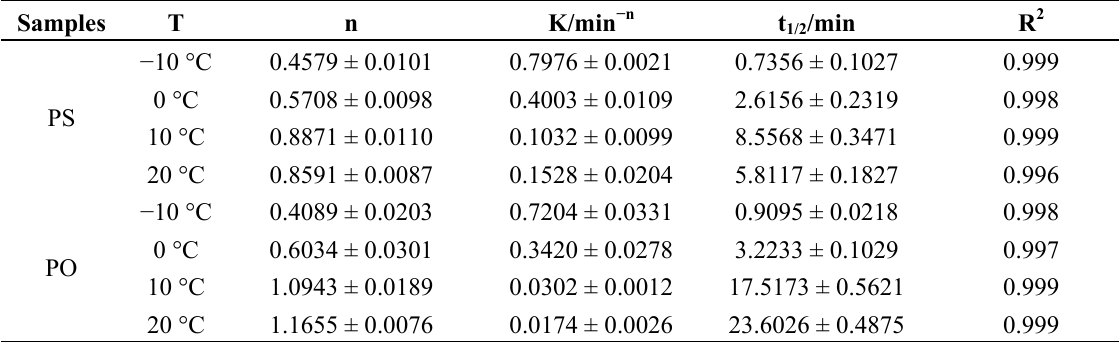
Table 3. Isothermal crystallization kinetic parameters for PS and